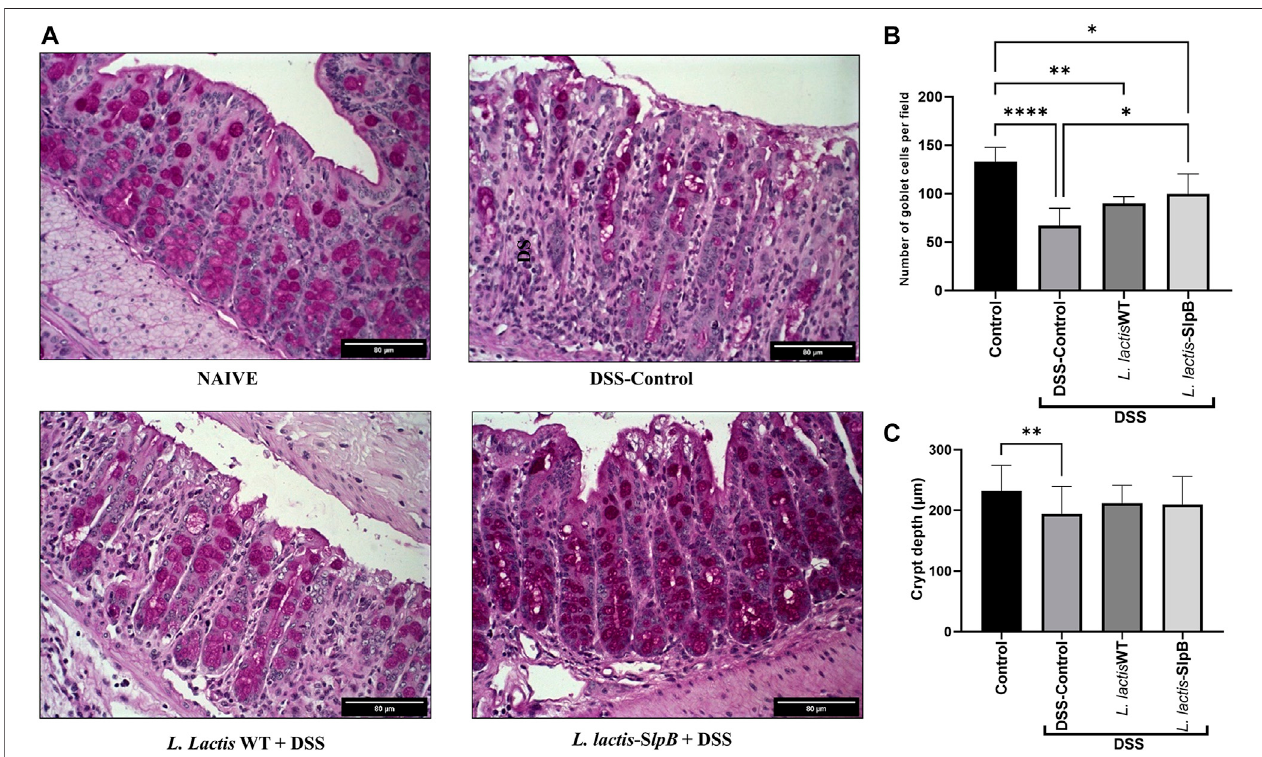
FIGURE 3 | L. lactis -SlpB mitigates histological signs of DSS-colitis. Model images of micrographs for analysis of goblet cells in colon tissue (A) and the result of goblet cell quanti fi cation by fi eld (B) and depth of colon intestinal crypts (C) are shown. The slides were stained in Periodic Acid-Schiff (PAS), goblet cells have intense purple-pink tones, and analyzed under × 40 magni fi cation. The data represent the mean ± SD of 12 mice per group. One-way ANOVAand Tukey ’ s post - hoc tests were used for multiple comparisons. Asterisks represent statistically signi fi cant differences as follows: p p < 0.05, pp p < 0.01, ppp p < 0.001, pppp p < 0.0001.